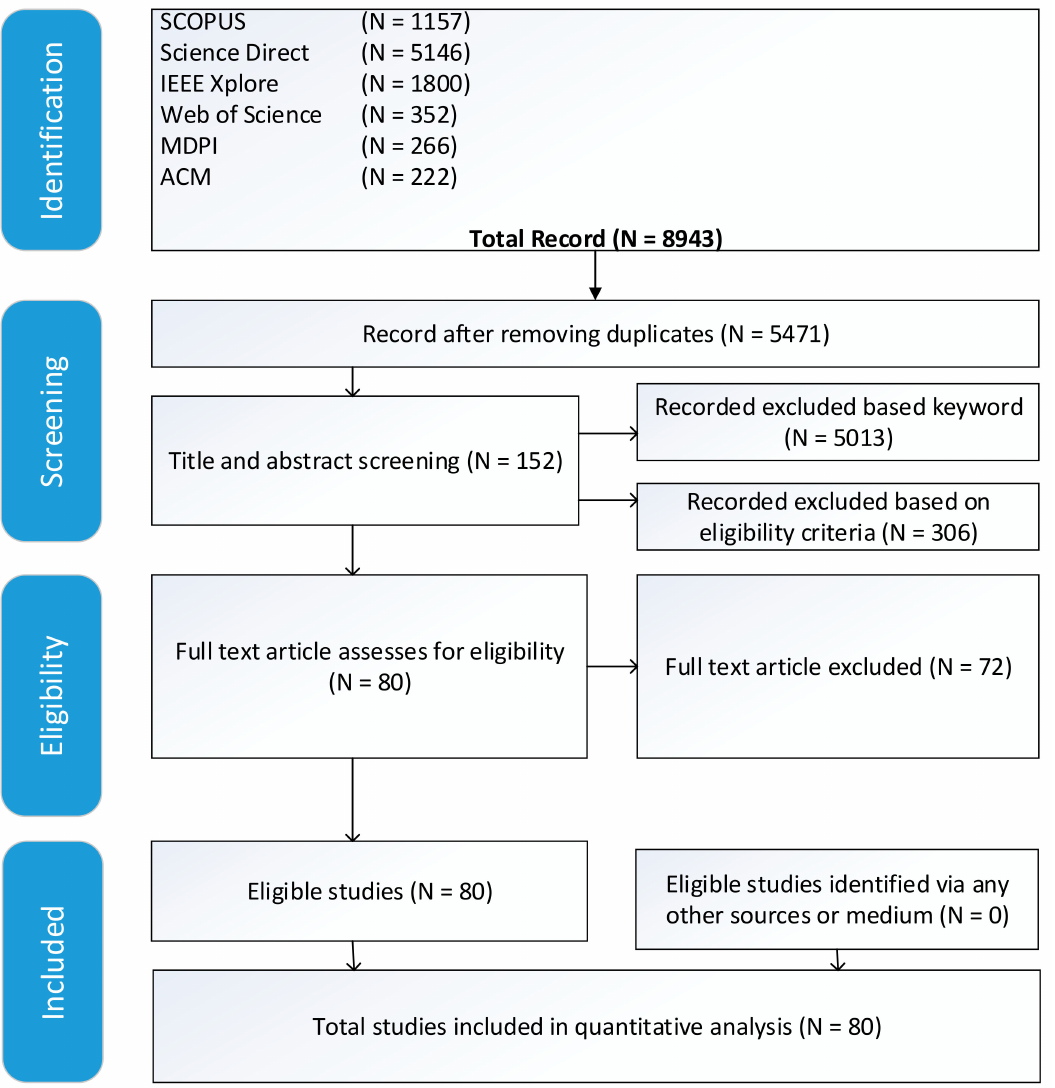
Figure 2. PRISMA flow diagram of studies’ screening and